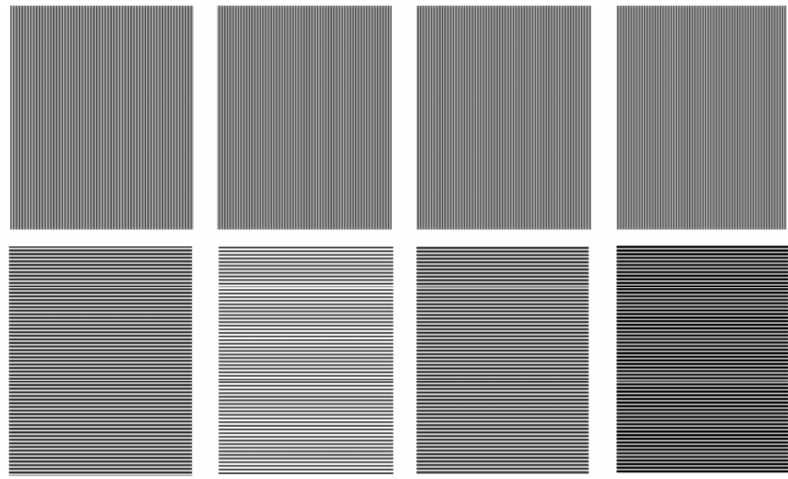
Figure 10. The four generated images in the first row are the vertical phase shifting fringe images I V ,I V ,I V , and I V , the corresponding horizontal phase shifting fringe images I H 2 3 1 4 shown in the second